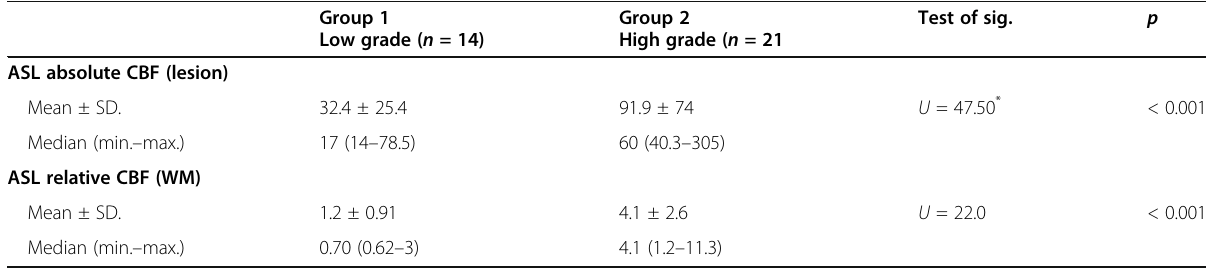
Table 3 ASL findings in the studied